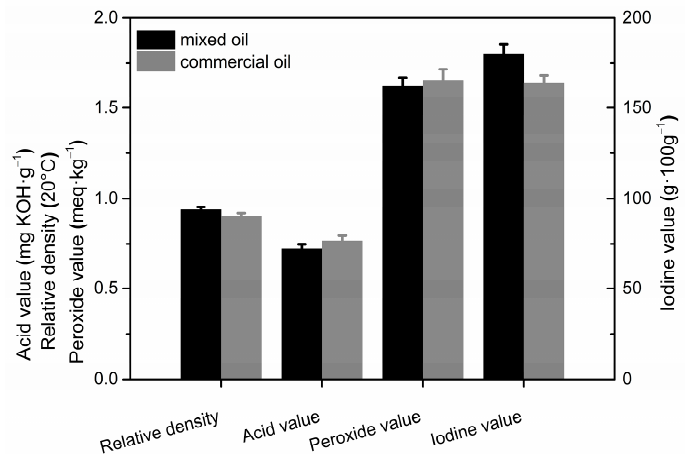
Figure 6. Comparison of physicochemical properties of peony seed oil obtained using different methods.